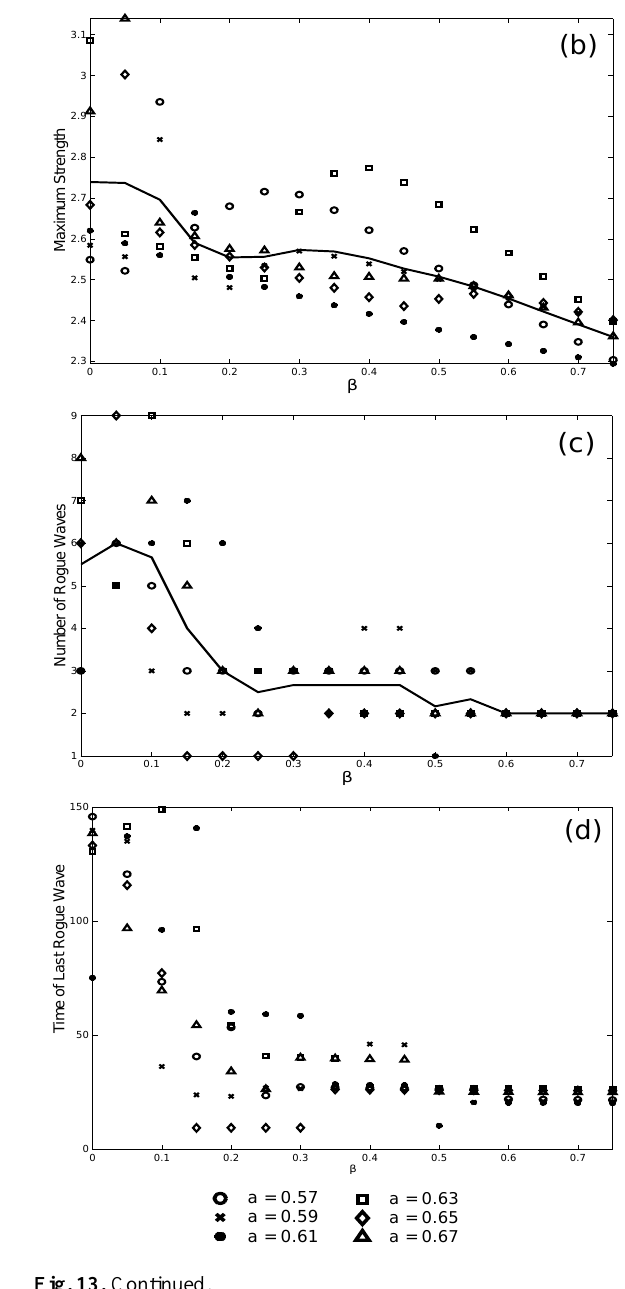
Fig. 13: The HONLS eqn. with nonlinear damping 0 < β < 0 . 75 , u 0 = a (1 + 0 . 01cos µx ) , 0 . 57 < a < 0 . 67 , (a) spectral center k m at t = 200 , (b) max t [0 , 200] S ( t ) , (c) number of rogue waves, and (d) time of last rogue wave as a function of β . The solid curves represent the averages.